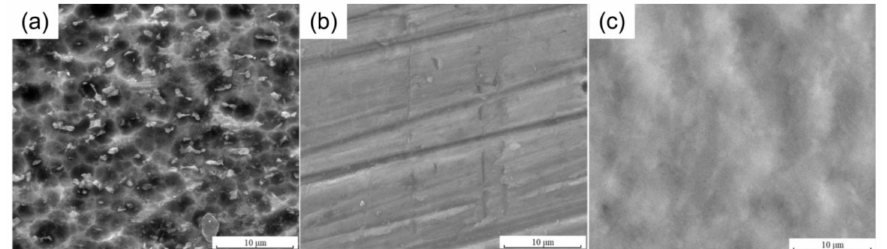
Figure 2. Surface morphology of TA15 titanium alloy: ( a ) Original sample ( b ) mechanical grinding, ( c ) laser